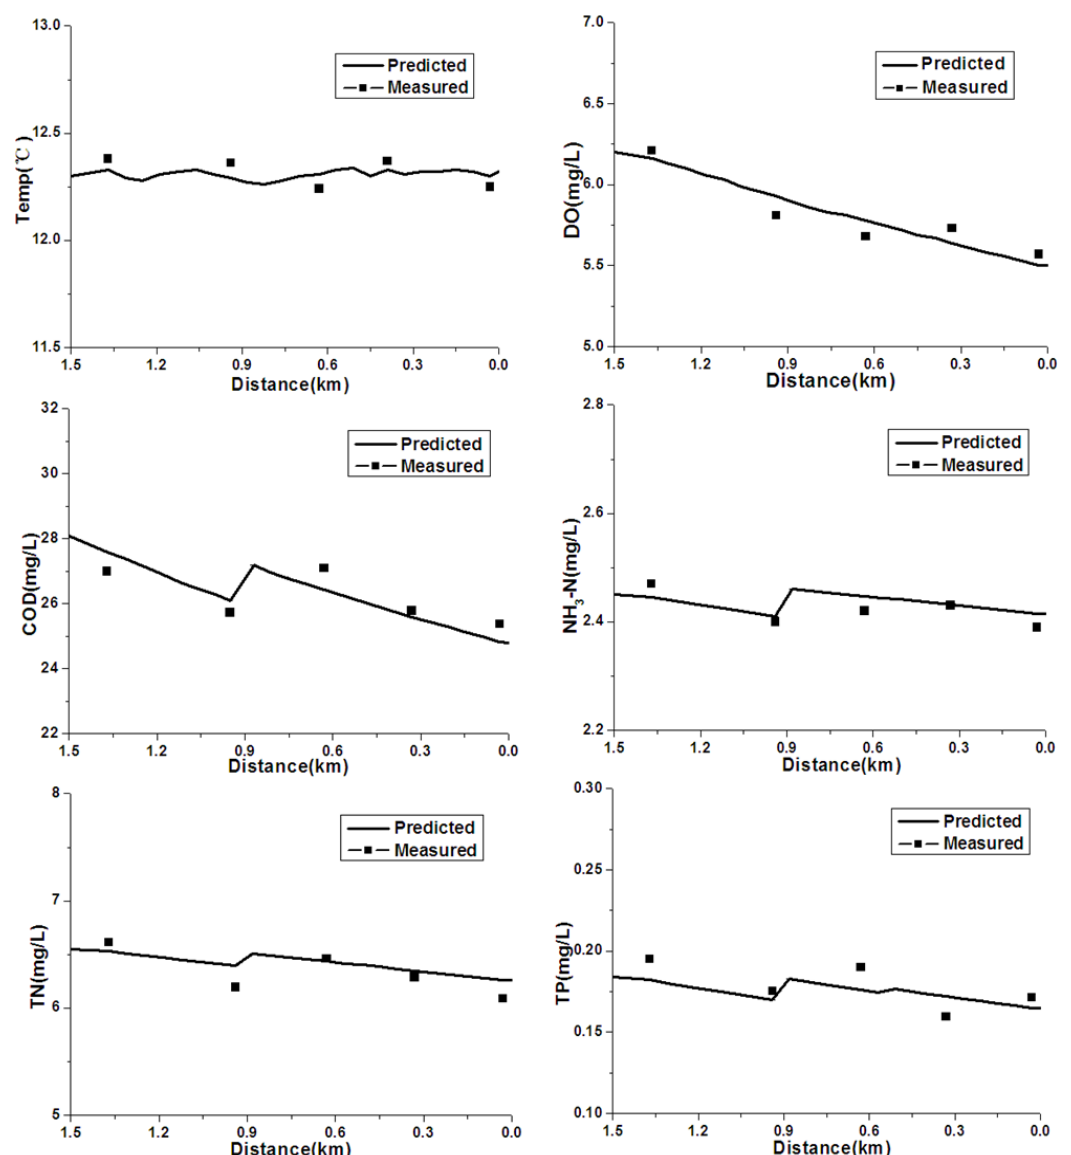
Figure 5. Water quality confirmation results for the Hongqi